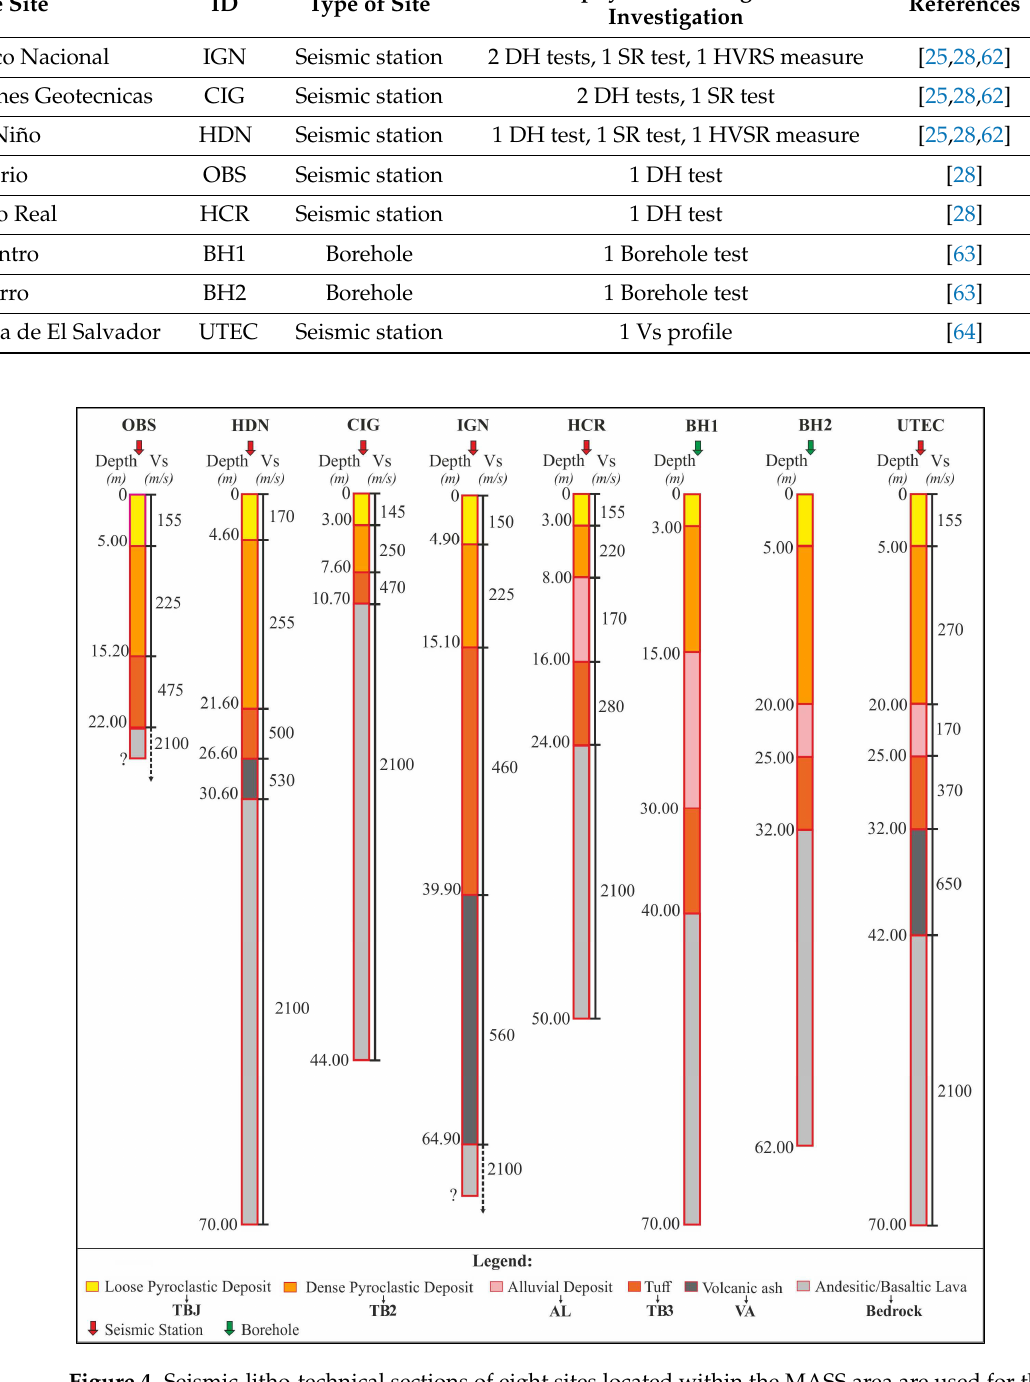
Figure 4. Seismic-litho-technical sections of eight sites located within the MASS area are used for the reconstruction of both subsurface models (AA′, BB′).